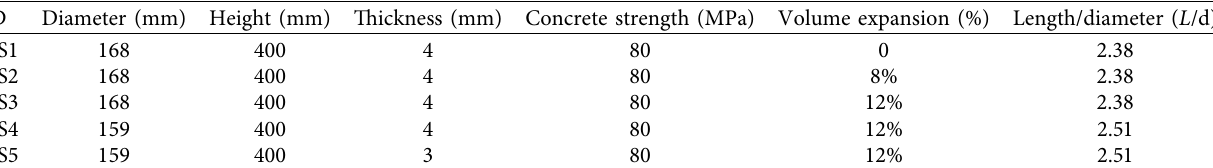
Table 1: Details of the specimens.